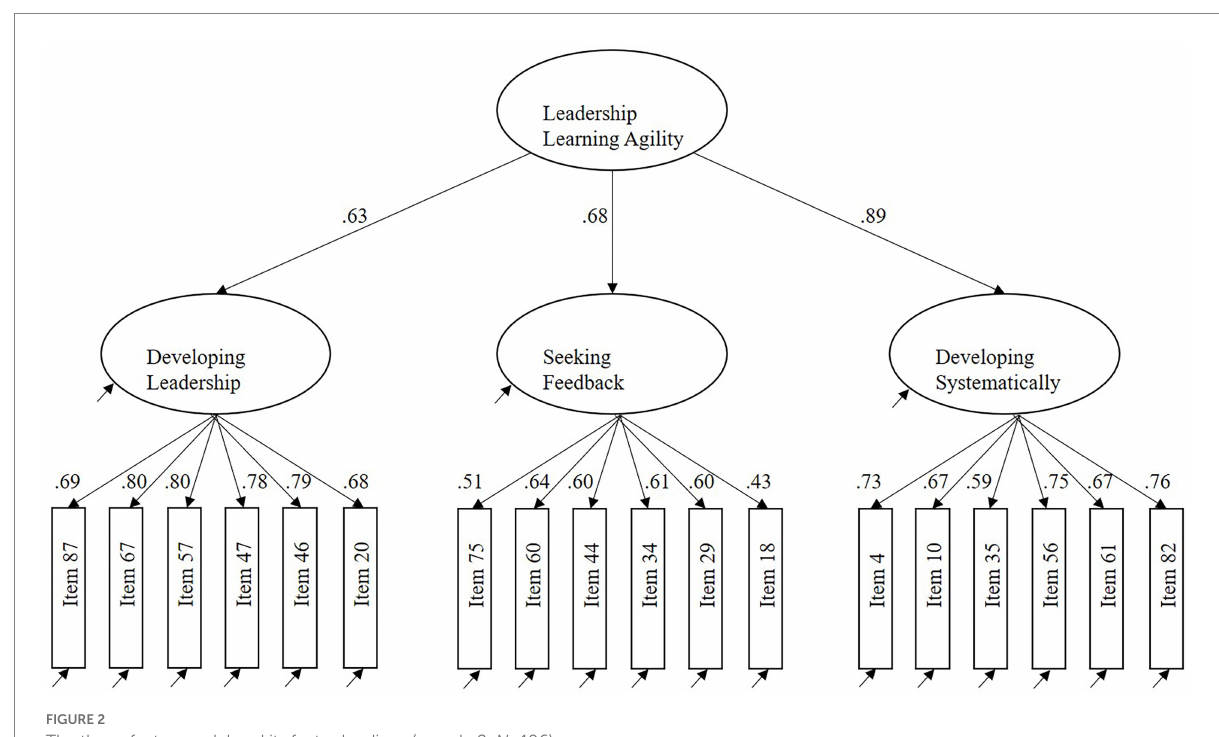
FIGURE 2 The three-factor model and its factor loadings (sample 2, N =